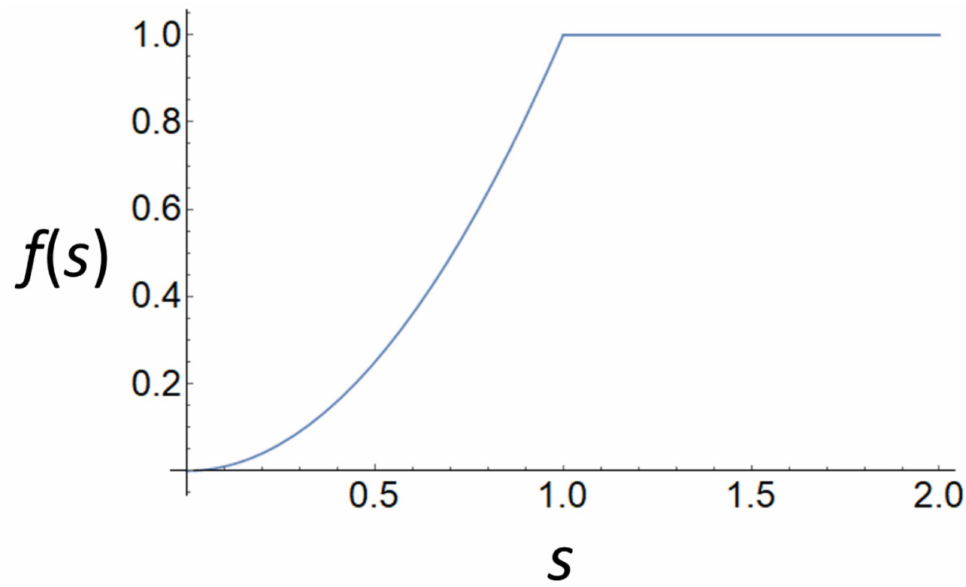
Figure A1. Equation (A8) with parameter values c = 1 and h =